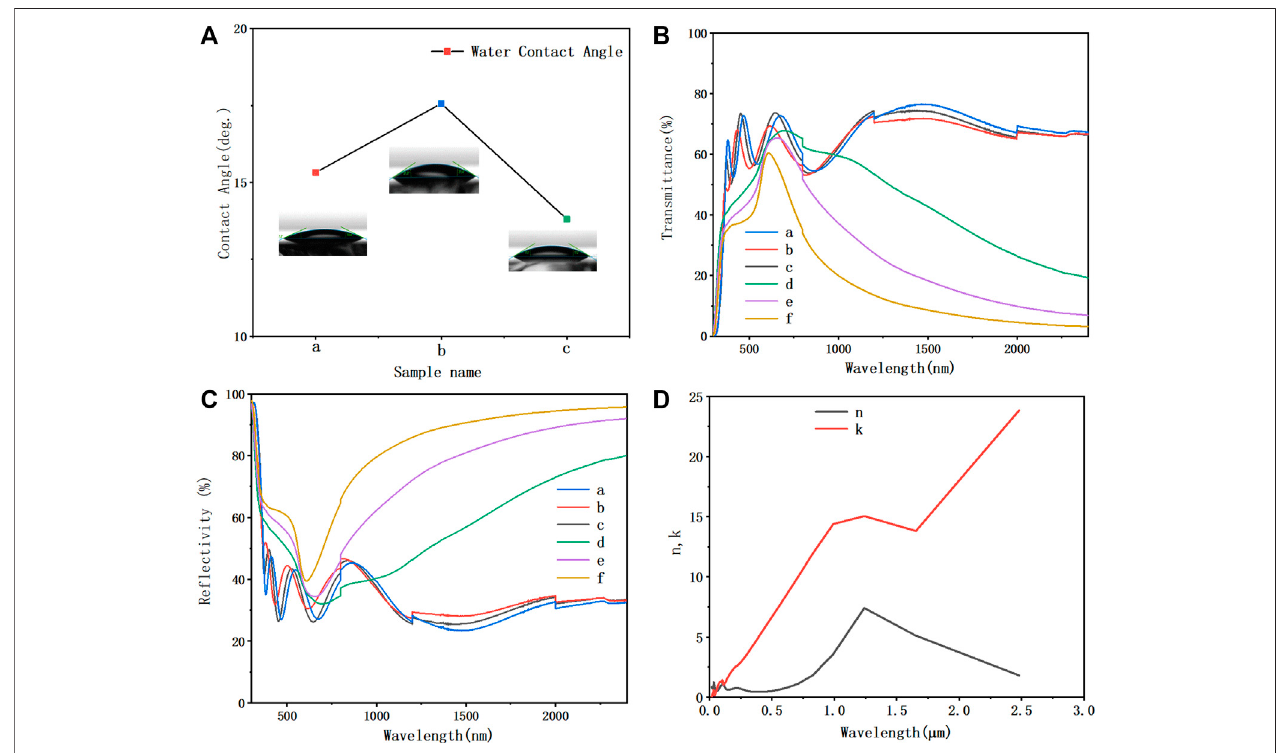
FIGURE 3 | (A) Contact angles for water with different fi lm thicknesses. (B) Re fl ectivity and (C) transmittance of multifunctional fi lms with different fi lm thicknesses. (D) Curves of refractive index n and extinction coef fi cient k of metal Mo with wavelength (different samples divided by sputtering time; a = 1800sWO 3 ,3sMo,4sNiCr,3600sTiO 2 ; b = 1800sWO 3 ,5sMo,4s,NiCr,1800sTiO 2 ; c = 1800sWO 3 ,5sMo,4sNiCr,3600sTiO 2 ; d = 1800sWO 3 ,45sMo,4sNiCr,3600sTiO 2 ; e = 1800sWO 3 ,70sMo,4sNiCr,3600sTiO 2 ; f = 1800sWO 3 ,95sMo,4sNiCr,3600sTiO 2